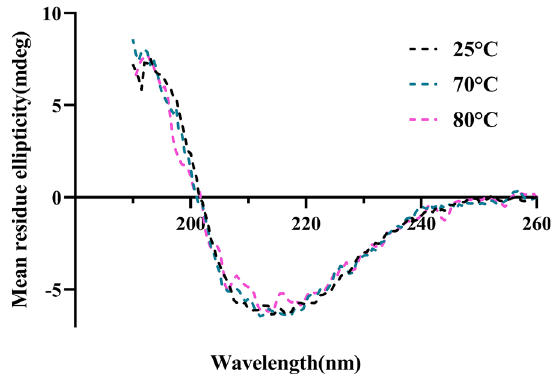
Fig. 4 CD spectra of the enzyme after incubation at different temperature